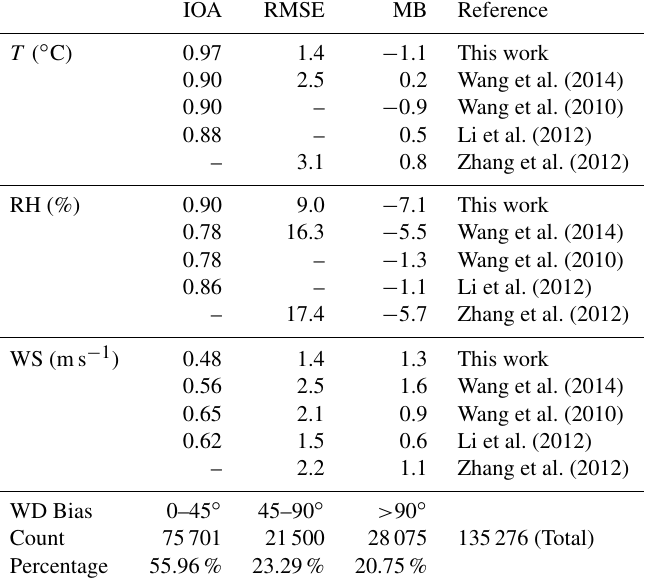
Table 3. Performance metrics (index of agreement (IOA), RMSE, and MB (mean bias)) of WRF-Chem simulated air temperature, relative humidity, wind speed, and direction at 284 meteorological sites in the North China Plain during 11–31 October 2018. The definitions of the metrics used in this study are given in Sect.